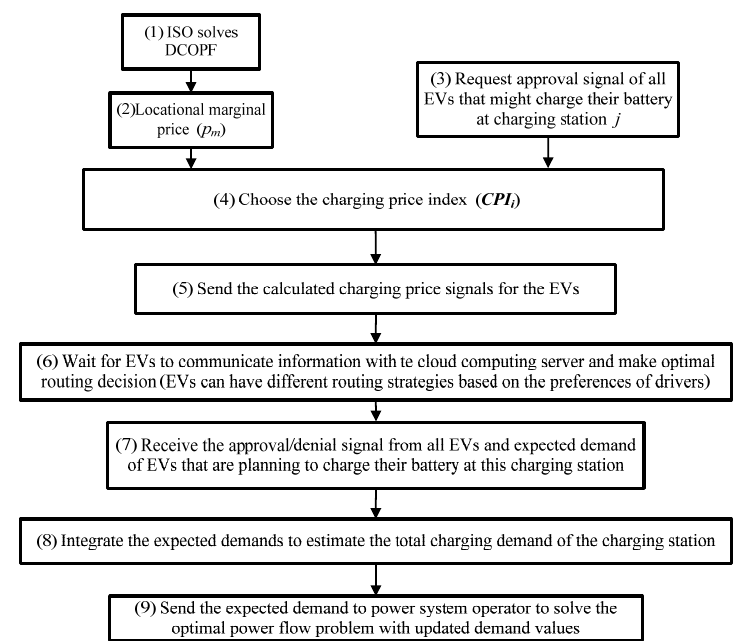
Figure 6. Charging station module representation. ISO: Independent System Operator.